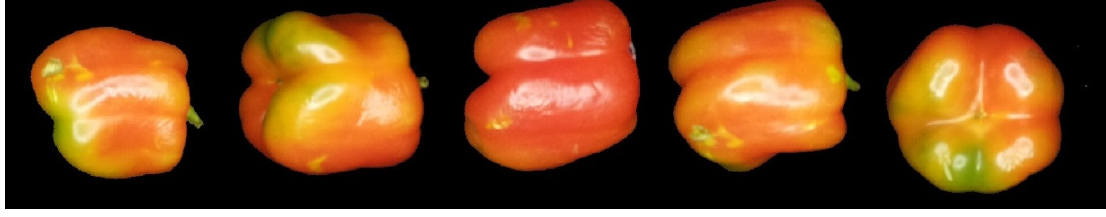
Figure 4. Images acquired by vision system.